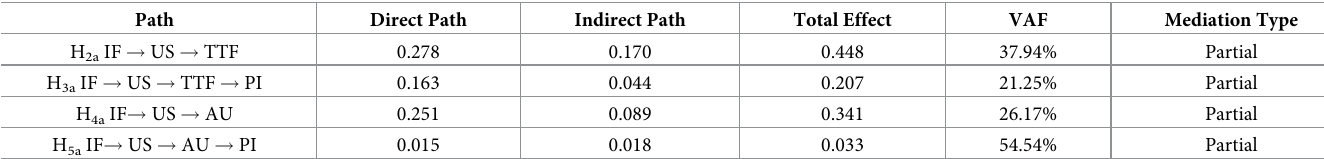
faction have indirect effect β = 0.170 and direct effect as β = 0.278, indicating partial mediation respectively. For the H mediation test, tests similar to those stated above were performed 3a indicating partial mediation effect, which represented that institutional factors firmly predict performance impact through the partial mediating role of user satisfaction and task technology fit in the sequence ( β = 0.044) and β = 0.163 as indirect and direct effects respectively. For test- ing H , mediation tests similar to those mentioned before were performed, β = 0.089 was the 4a indirect effect and β = 0.251 was the direct effect showing partial mediation. So, H is sup- 4a ported, and hence institutional factors positively predict actual usage of the system through the partial mediating role of user satisfaction. For verification of H similar tests of mediation 5a, aforementioned were performed, and found indirect and direct effects β = 0.018 and β = 0.015, respectively. Therefore, H is verified, so institutional factors positively predict performance 5a impact through the partial mediating role of user satisfaction and actual usage of the system. Hayes Process Macro for Moderation was utilized to test for moderation to test H , which 6 claims that cognitive absorption moderates the relationship between institutional factors and user satisfaction [132]. The test results are displayed in Table 8, where Coeff is the coefficient, SE represents the standard error, T represents the T-test, and the value of T should be greater than 1.96 to accept the alternative hypothesis. P is the significance value, and its value should be less than .05 to accept the alternative hypothesis. The last two columns, LLCI and ULCI, are the lower and upper intervals for the coefficient values, and they should not contain zero val- ues to accept the alternative hypothesis. At first, the total direct effect of institutional factors was tested on user satisfaction; the output represented a significant interaction impact of insti- tutional factors on user satisfaction ( β = 0.749; t = 10.719; p < 0.001). Likewise, the direct effect of cognitive absorption as a moderator on user satisfaction was tested; the output represented a significant interaction impact of cognitive absorption on user satisfaction ( β = 0.5014; t = 10.6868; p < 0.001). Finally, we tested the interaction effect of institutional factors and cog- nitive absorption on user satisfaction; the output represented that cognitive absorption has a significant interaction impact on user satisfaction ( β = -0.1566; t = 4.5098; p < 0.001). Since the interaction term is crucial to determine the effect, the moderation effect exists in our